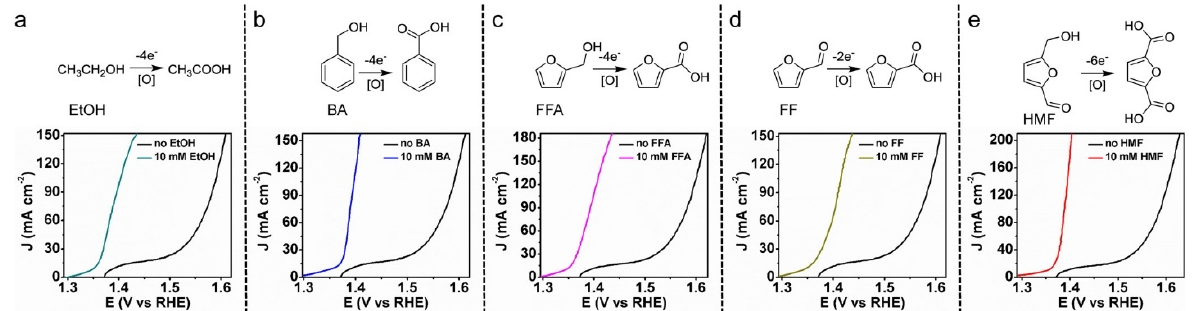
Figure 3. ( a − e ) Oxidation of selected important biomass-derived organics to value-added products and corresponding linear sweep voltammetry curves with or without 10 mM of the organic sub- strates (10 mM, pH = 14, scan rate of 2 mV s − 1 ), using a nickel foam. Reprinted with permission from Reference [95]. Copyright 2016 American Chemical